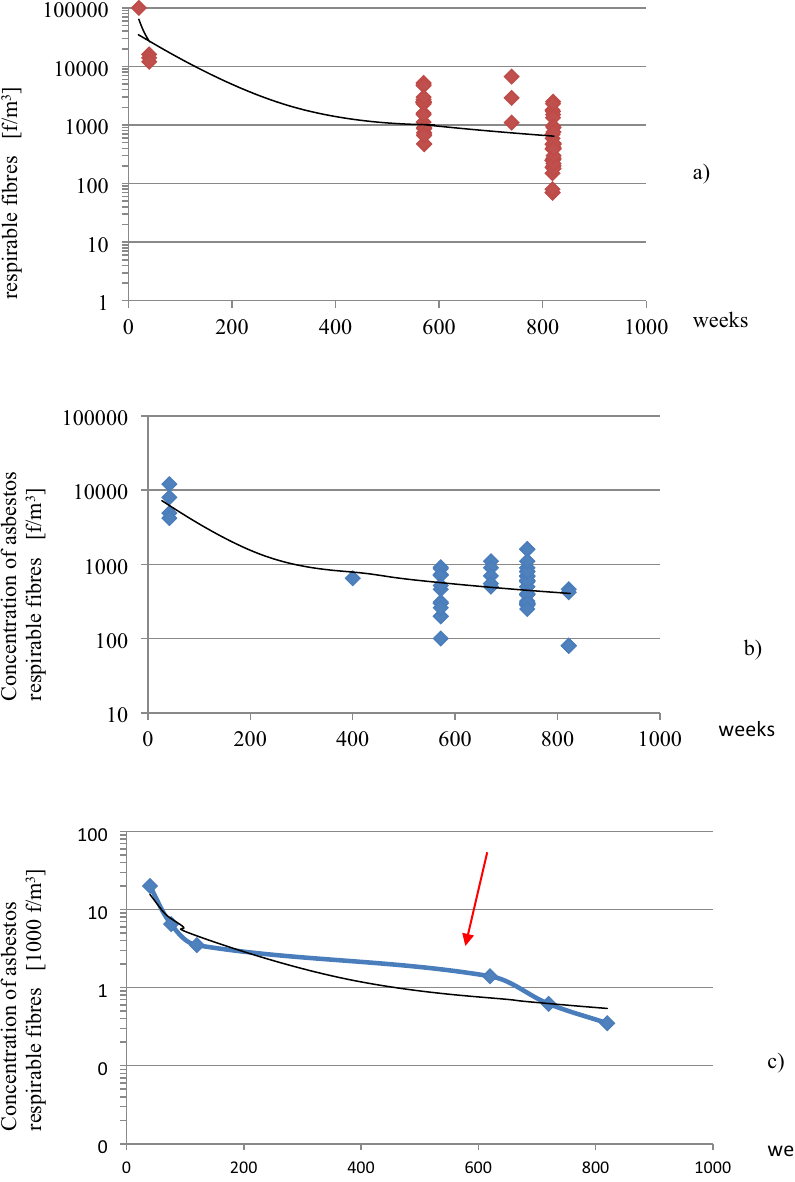
Figure 3. Analysis of changes in asbestos concentration in the BOLETICE building. ( a ) Results of dust concentration in the building during dynamic sampling. ( b ) Results of dust concentration in the building during static sampling. ( c ) Averaged concentration values from static and dynamic sampling in the BOLETICE building as a blue curve. The trend of change is represented by the black curve. The red arrow marks the end of building